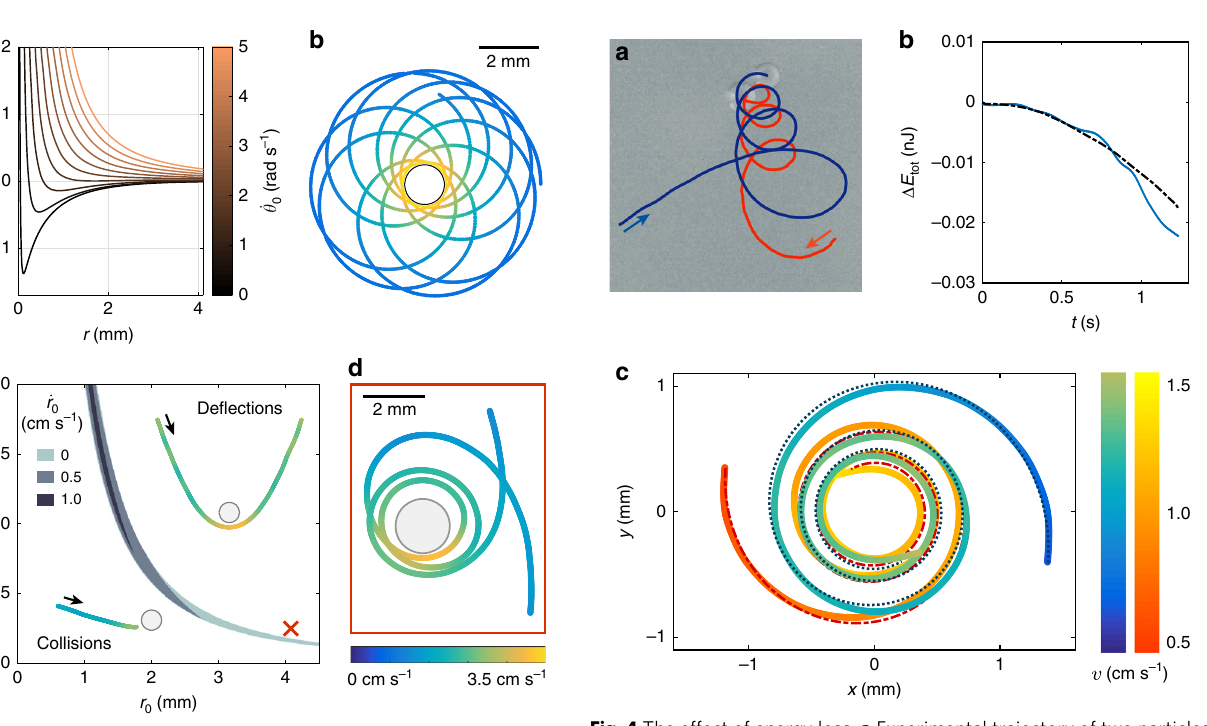
Fig. 3 Classi fi cation of capillary orbits. a Effective potential U eff as a function of distance r , for varying initial angular velocity _ θ 0 . The particle masses and their initial distance are kept constant ( m r ¼ 9 : 10 (cid:2) 8 kg, and r 0 = 4.1 mm). b Example of a bounded orbit for this potential, with initial conditions _ θ 0 = 1.465 rad s − 1 and _ r 0 = 0. See also Supplementary Movie 7. c Phase diagram to classify orbits, expressed using the initial conditions r 0 , _ θ 0 for m ¼ 9 : 10 (cid:2) 8 kg. The upper region corresponds to de fl ections and the lower r region to collisions, both illustrated by experimental trajectories. Bounded orbits without collisions are only observed in a narrow band plotted in shades of gray, for varying radial velocities _ r 0 . The initial conditions of ( d ) are indicated by a red cross. d Experimental trajectory close to a bounded orbit in the center of mass frame. See also Supplementary Movie 8